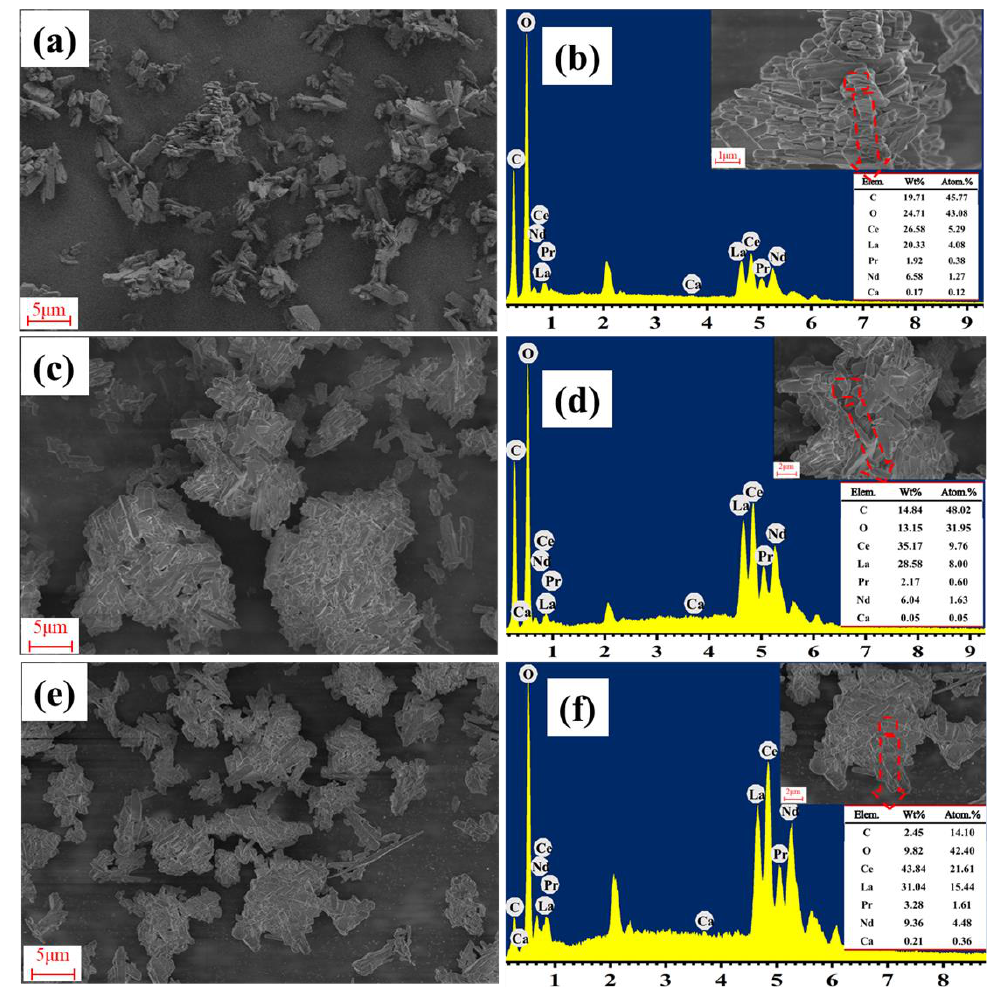
Figure 13. SEM-EDS analysis results of oxalic acid precipitation products ( a , b ) and their roasted products at 200 °C ( c , d ) and 600 °C ( e , f ).